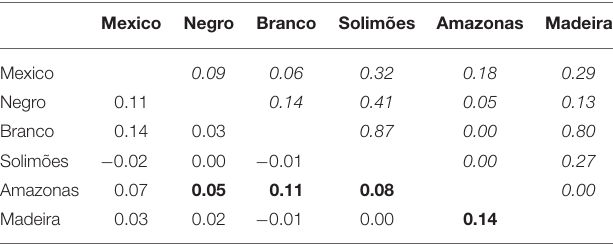
( Figure 3A , yellow and green clusters) and occurrence of wild Mesoamerican alleles in cultivated Amazonian C. cujete samples.